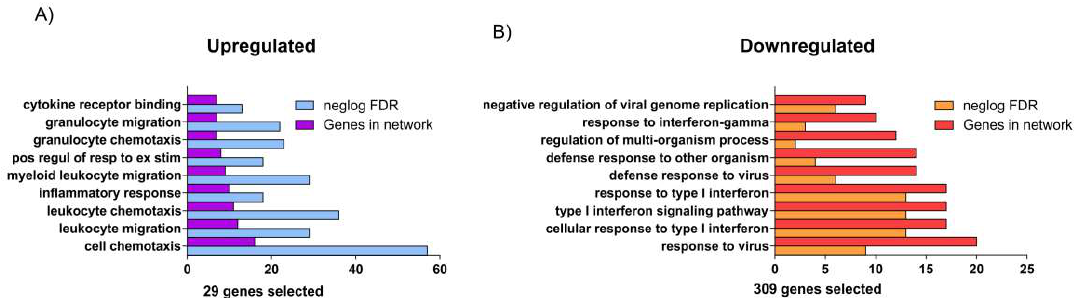
Figure 1. The Gene Ontology analysis: ( A ) The dataset analysis showed that the 29 upregulated genes were involved in several immunological processes. The most significant process was Cell Chemotaxis (the negative Log of FDR (ngLogFDR) was 58, and the genes involved (GI) were 18). ( B ) The 309 downregulated genes identified during the GSE58682 analysis belong to the response to type I interferon (FDR = 14, GI = 16). Interestingly, the ability of antiviral response in subjects exposed to the ozone was significantly impaired.